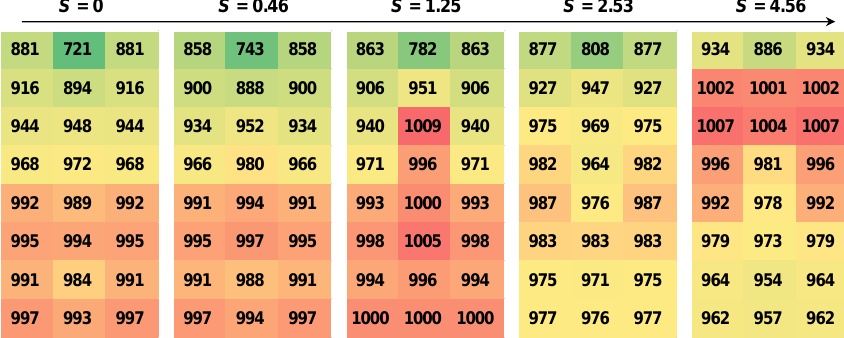
Figure 8. Temperature distributions for various swirl numbers at p = 150 kPa and ϕ = 0.8.